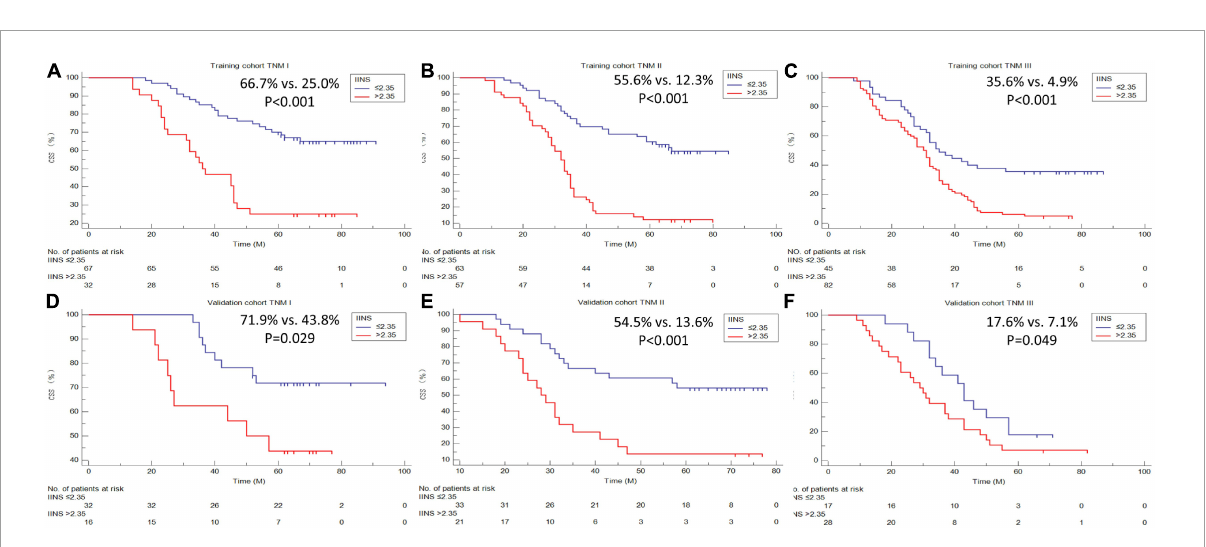
FIGURE7 Cancer-specific survival (CSS) analyses grouped by tumor node metastasis (TNM) stages. Subgroup analyses based on TNM stage in the training cohort (A–C) and validation cohort (D–F)